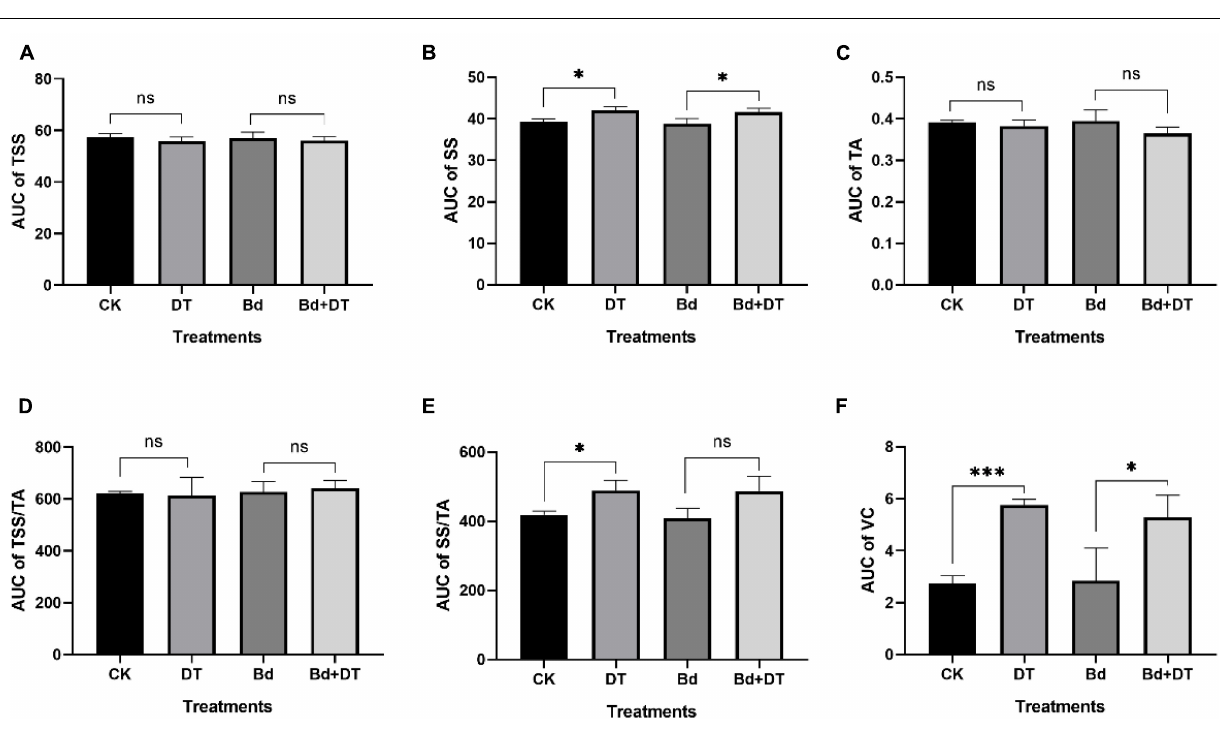
Frontiers in Microbiology |